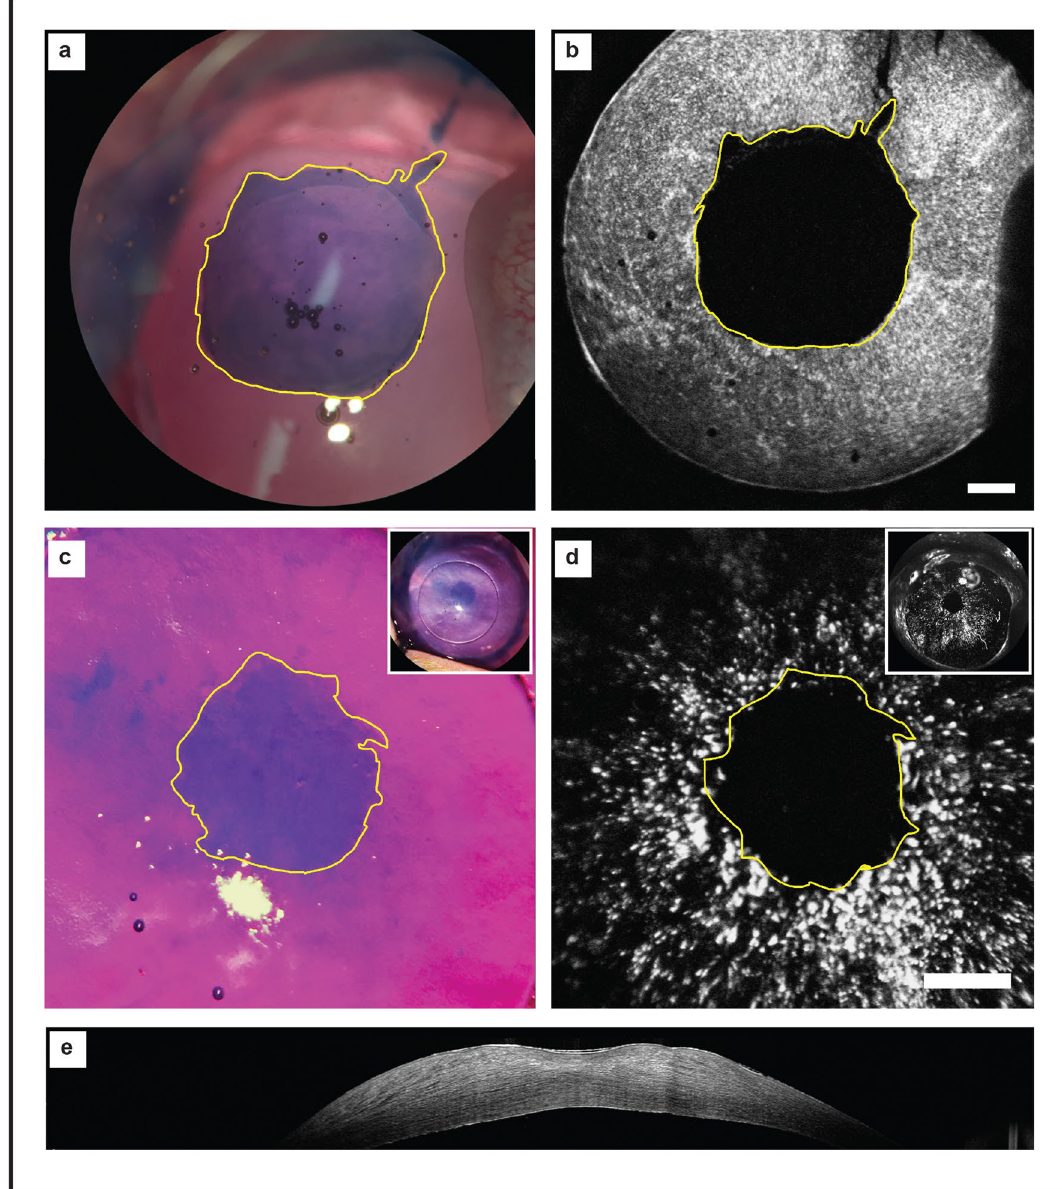
Figure 5. Comparison between in vivo DIR imaging and trypan blue staining. ( a ) Intra-operative trypan blue staining shows bare DM where endothelial cells have been removed by scraping. ( b ) The same eye was imaged immediately post-operatively. The DIR imaging of the area of denuded endothelial cells shows good concordance with intraoperative trypan blue (yellow outline), where DIR fluorescence is blocked by the nictitating membrane. At 3 days post-wounding, significant closure of the wound can be seen. ( c ) Injection of intracameral trypan blue stains a small residual area bare DM (yellow outline). A feathered edge is observed, representing migrating endothelial cells. ( d ) Infrared imaging of the same eye shows the same area of bare DM, surrounded by fluorescent endothelial cells (yellow outline). ( e ) An OCT image of the cornea at day 3 post wounding confirms DIR images are successfully acquired through thickened and irregular corneas. Scale bar: 1 rescence for the entire study period. DIR images of the graft were taken at the pre-implantation (Fig. 9a) and post-implantation (Fig. 9b), and at intervals from day 1 to day 28 (Fig. 9c–e) in conjunction with infra-red (Fig. 9f–j), and OCT (Fig. 9k–o). The yellow bordered figures (Fig. 9p–q) is the magnified area denoted by the yellow arrows (Fig. 9a,b,d,e), whereas the blue bordered figures (Fig. 9r,s) is the magnified area denoted by the blue arrows (Fig. 9c–e). At day 1 post implantation, areas of bare DM devoid of endothelial cells were visible (Fig. 9c; red arrows). A triangular orientation mark (yellow arrow) used to confirm the correct position was also clearly visible. Over the first week, cells migrated to cover the areas of the bare DM (Fig. 9c; red arrows). Areas of